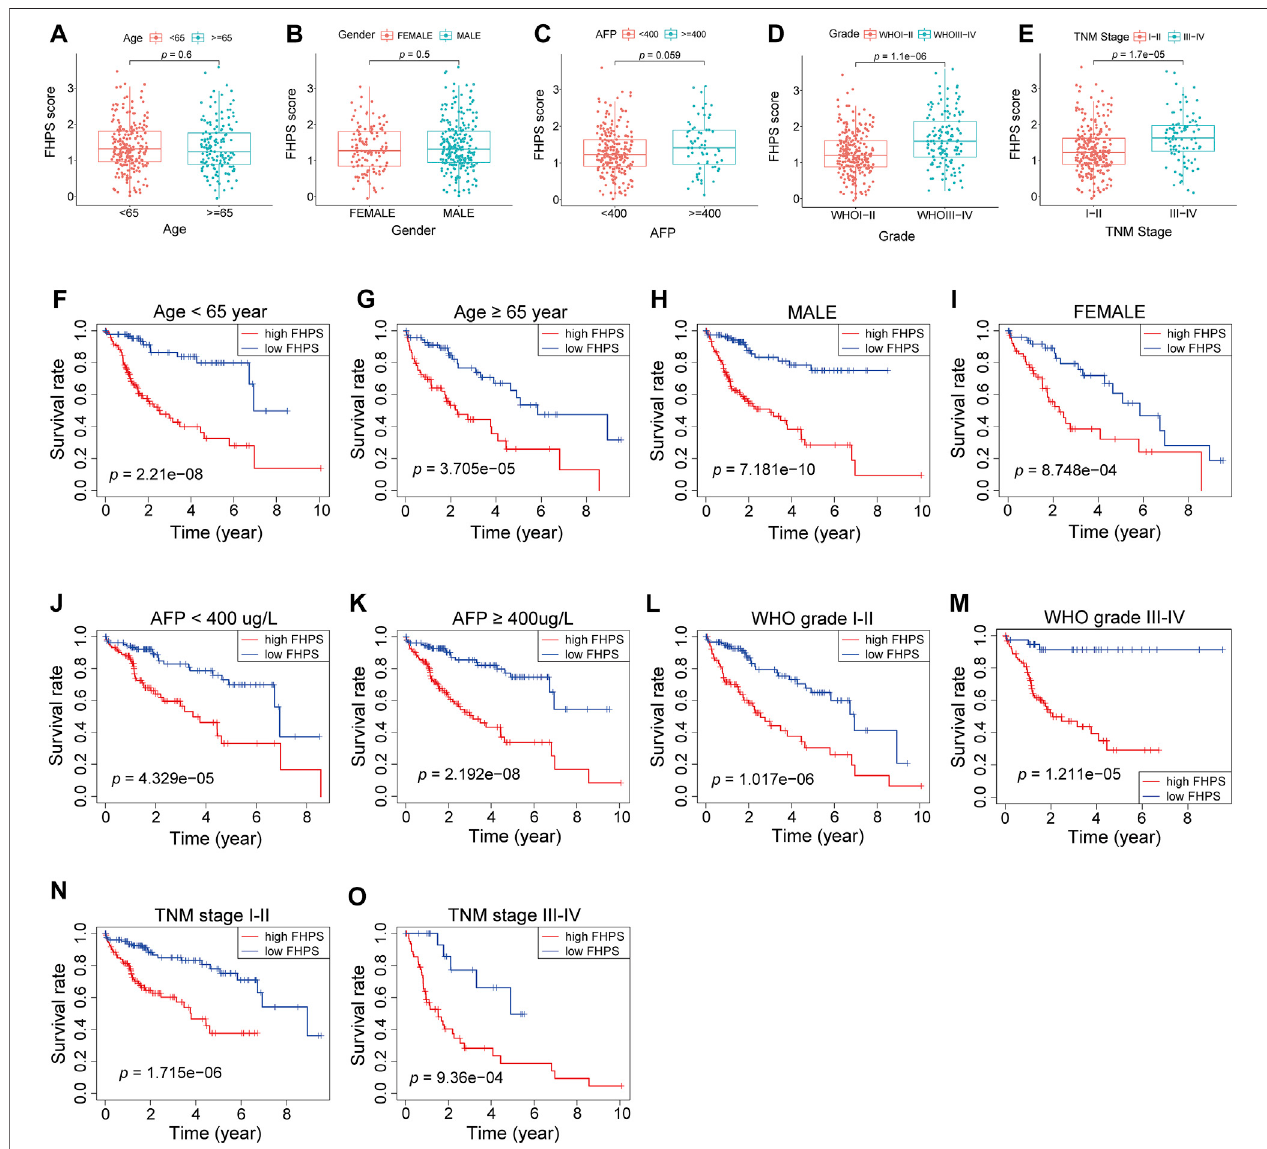
FIGURE4|(A – E) Patientswithdifferentclinicopathologicalfeatures(includingWHOgradeandTNMstage,butnotAFPvalue,age,andgender)haddifferentlevels of FHPS scores. (F – O) The FHPS retained its prognostic value in multiple subgroupsof HCC patients (including patients with WHO grade III-IV or I-II, TNM stage III-IV